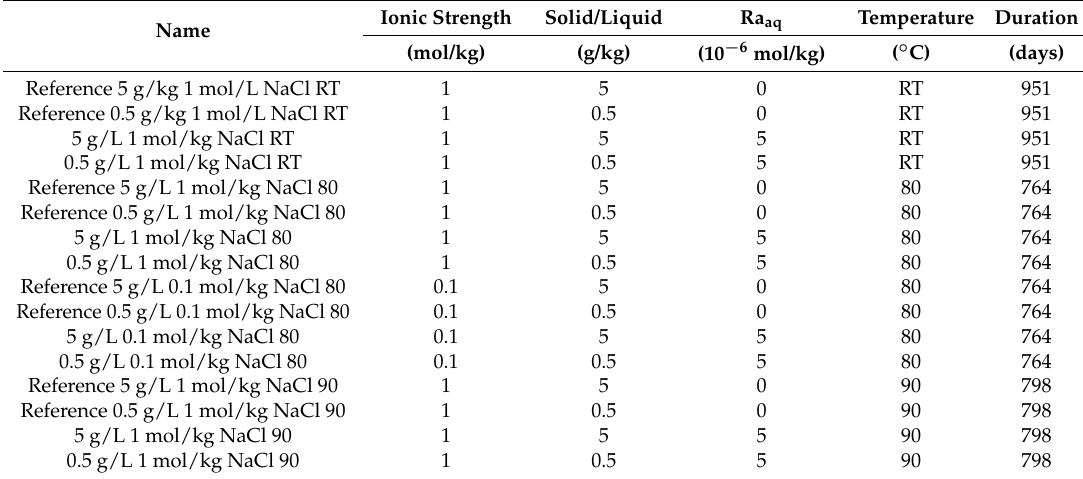
Table 1. Overview of experiments at elevated ionic strength.